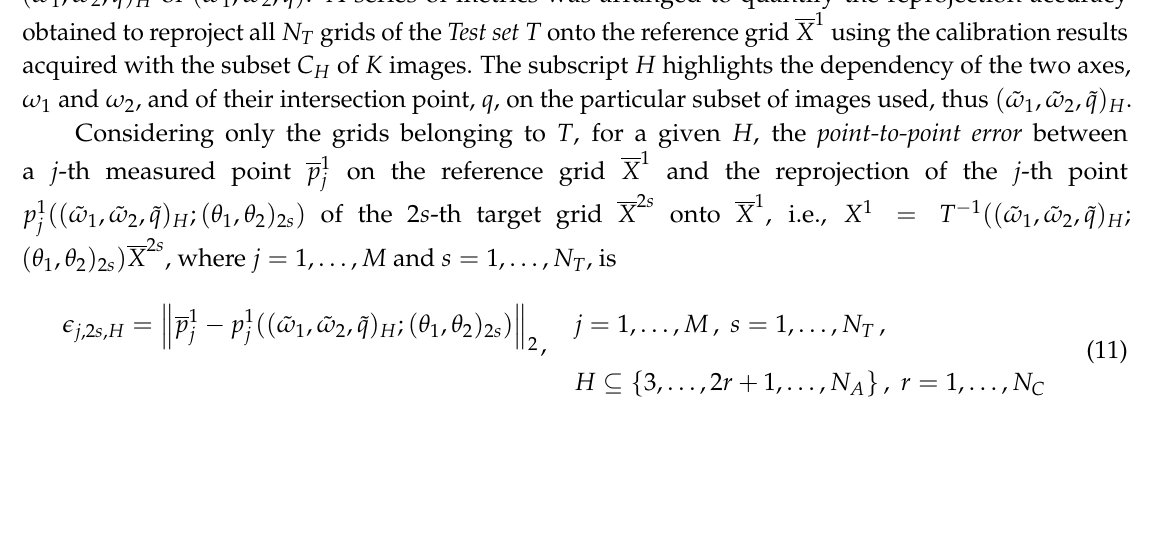
Figure 8. The two measured grids of Figure 7 in the operative space: ( a ) reference grid ( X R , in red; as in Figure 7a) and target grid ( X i , in blue; as in Figure 7b); ( b ) reference grid (in red), and target grid rotated by ( θ 1 , θ 2 ) i onto the reference grid ( X R , in blue); virtually identical because of the low reprojection